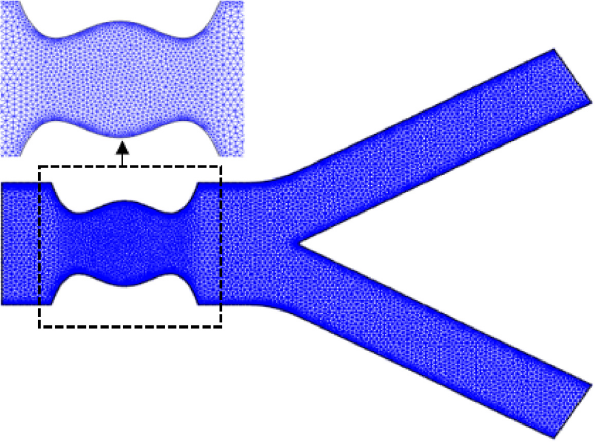
Fig 5. The meshing selected containing 12735 triangular elements for τ